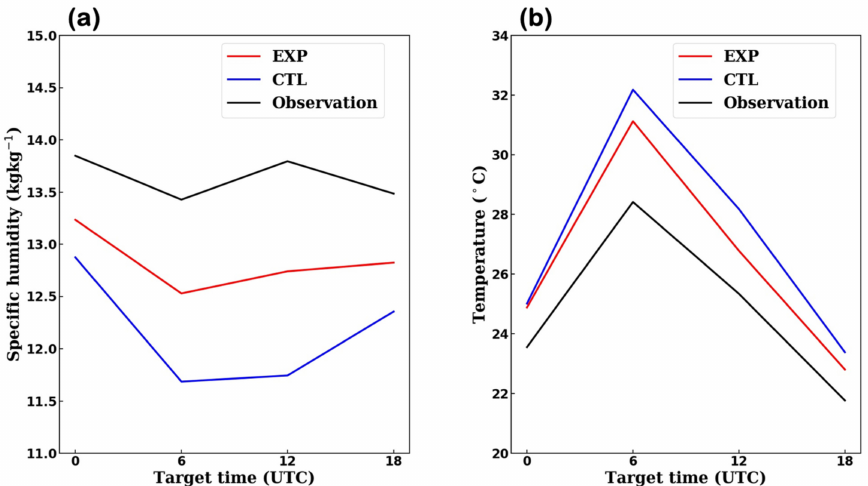
Figure 15. Diurnal cycle of ( a ) the near-surface-specific humidity and ( b ) near-surface air temperature at latitude 44.57 ◦ N, longitude 120.9 ◦ E in the observation and model forecasts (EXP and CTL); the 114-h forecast for the 06, 18Z cycle and 120-h forecast for the 00, 12Z cycle were